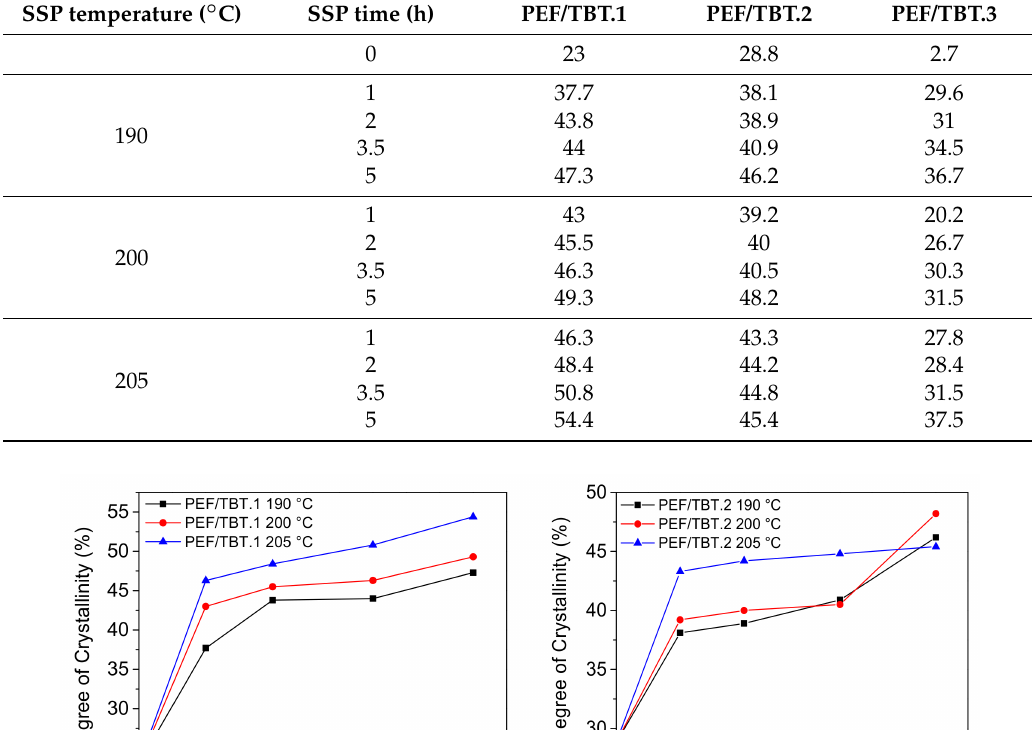
Table 4. Degree of crystallinity values (%) of the different SSP PEF/TBT samples.